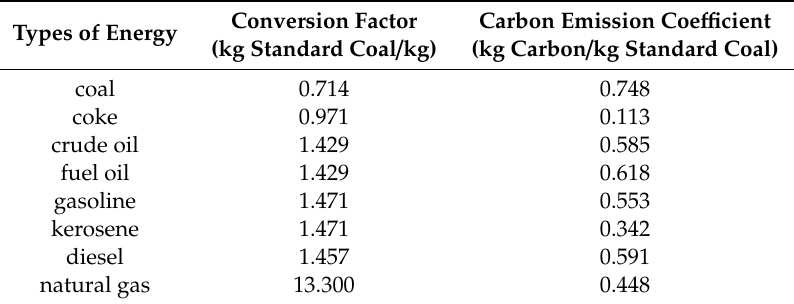
Table 3. Carbon emission factors of various energy